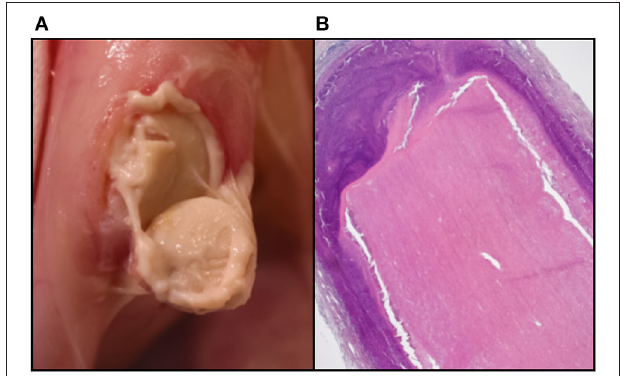
FIGURE 1 | Sterile granulocytic pus response to SDS-based decellularization of porcine aortic wall in the rabbit subdermal model. (A) Macro photo at time of retrieval. (B) Haematoxylin & Eosin histology showing thick granulocytic rim surrounding the